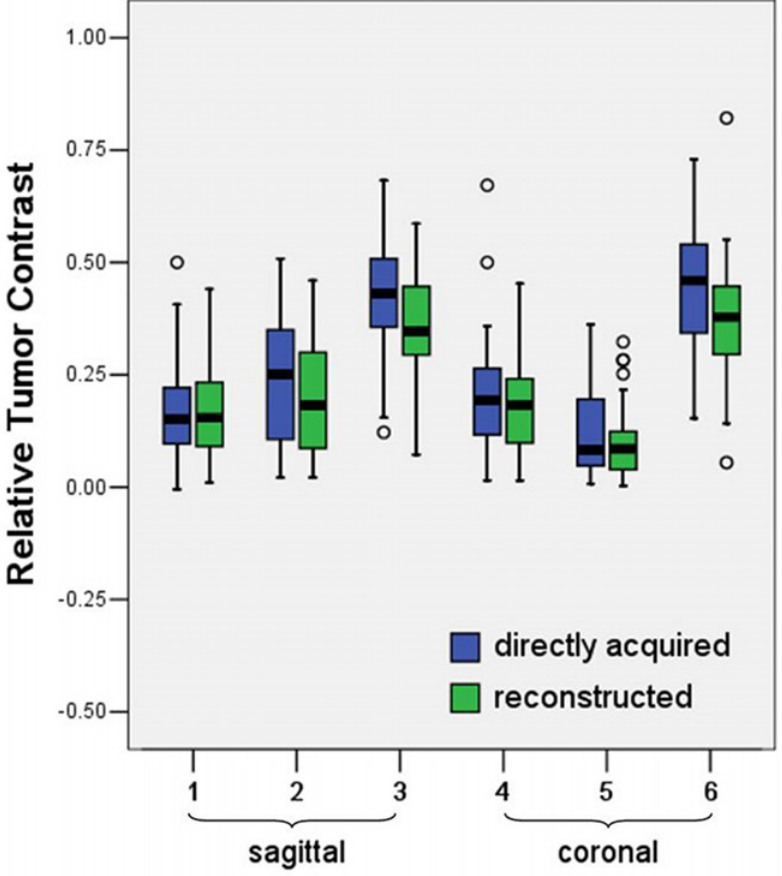
Fig 3. Box and whisker plots of relative tumor contrast. The relative tumor contrast between tumor to gluteal muscle and between tumor to fat in the directly acquired were higher than those in the reconstructed images ( p = 0.001 and 0.031, sagittal; both p < 0.001, coronal). While the relative tumor contrast between tumor to myometrium was not statistically different for directly acquired and reconstructed either on sagittal or coronal images ( p = 0.642 and 0.171, respectively).